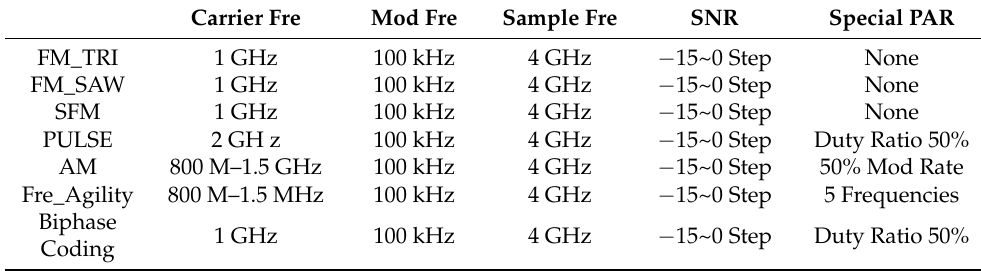
Table 2. Experiment parameters (Single Classes).